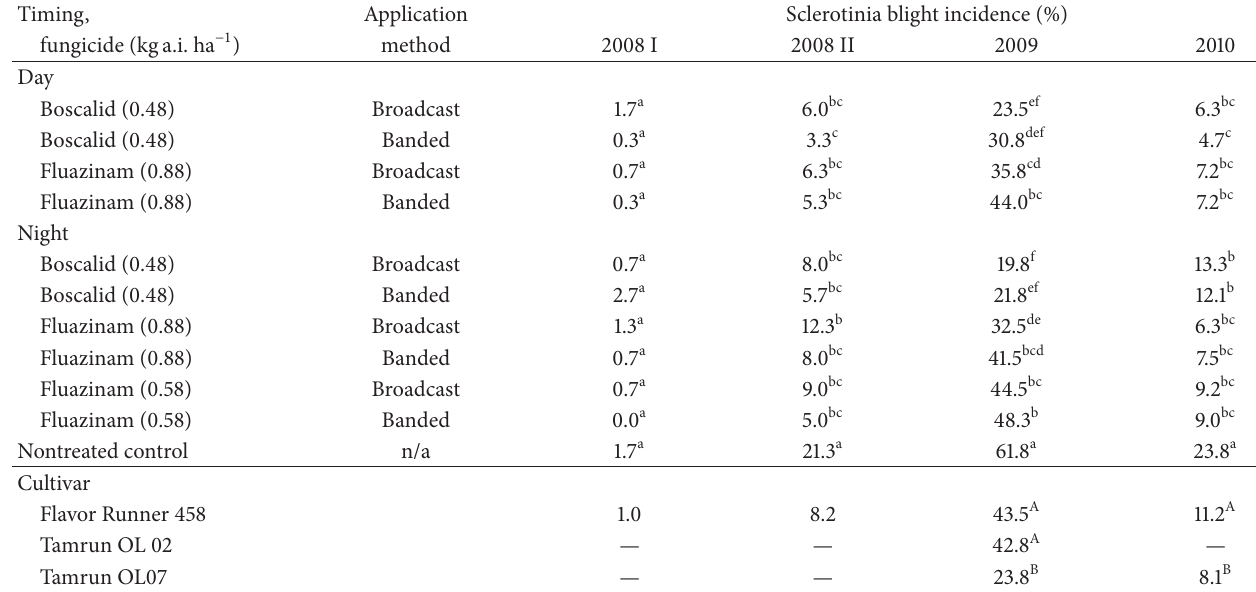
Table 3: Effect of broadcast and banded applications of the fungicides boscalid and fluazinam applied at different times of the day on Sclerotinia blight of peanut a